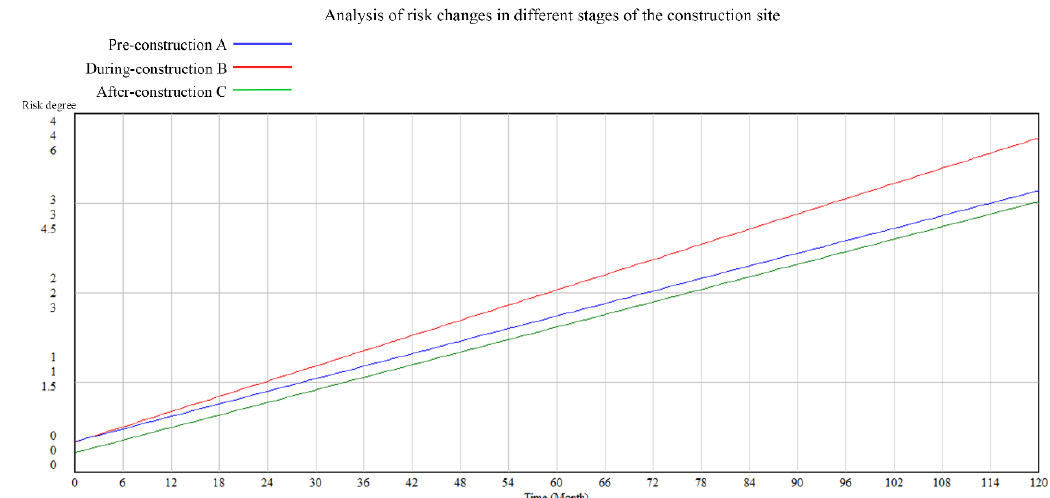
Figure 5. Analy-sis of risk changes in different stages of the construction